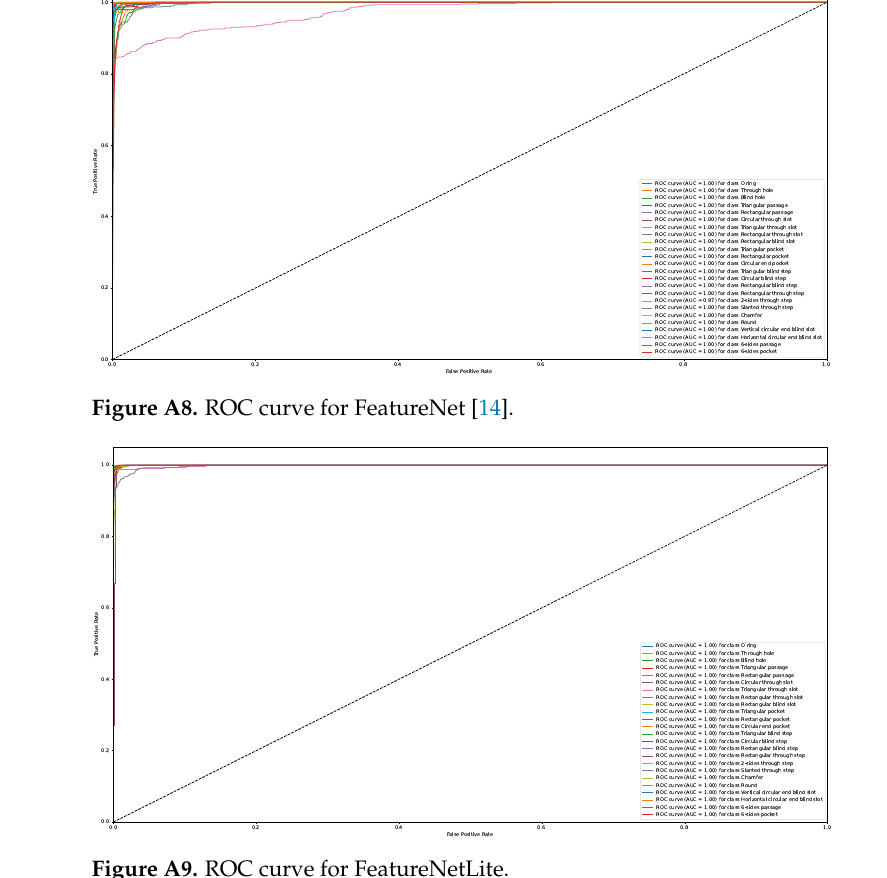
MsvNet Multiclass ROC Curve